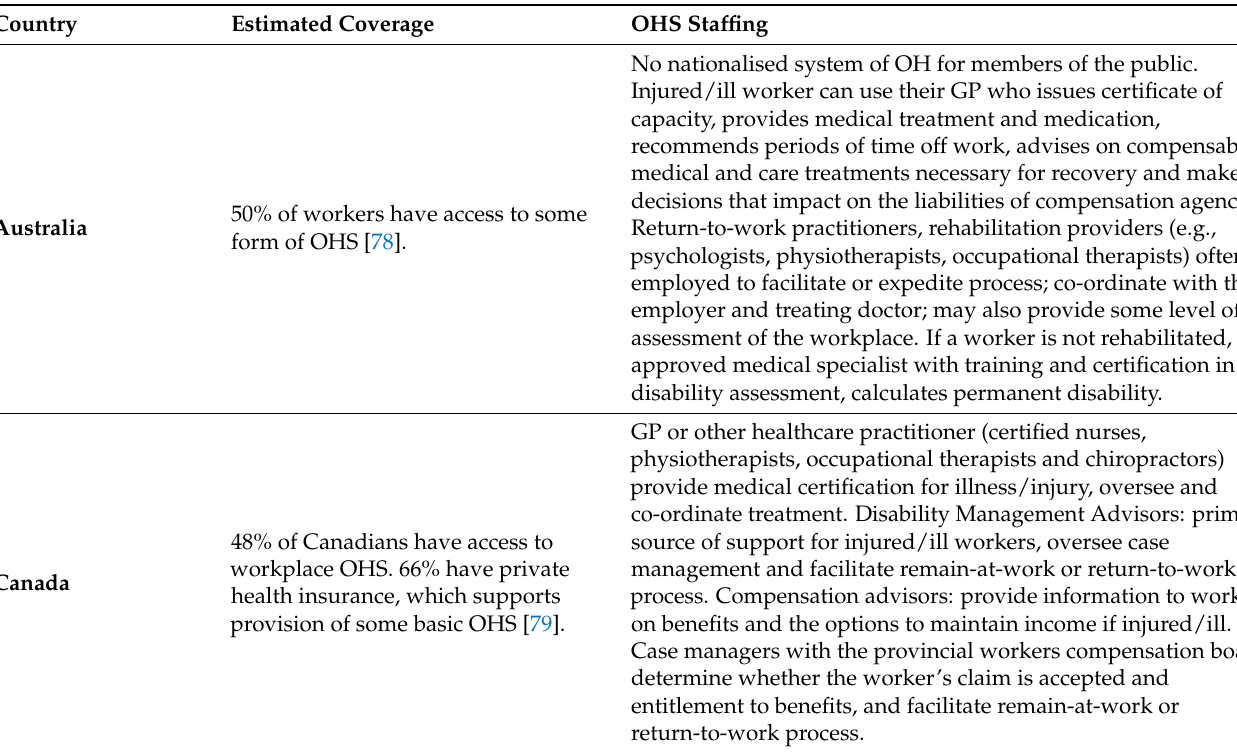
Table 4. Coverage and staffing of occupational health